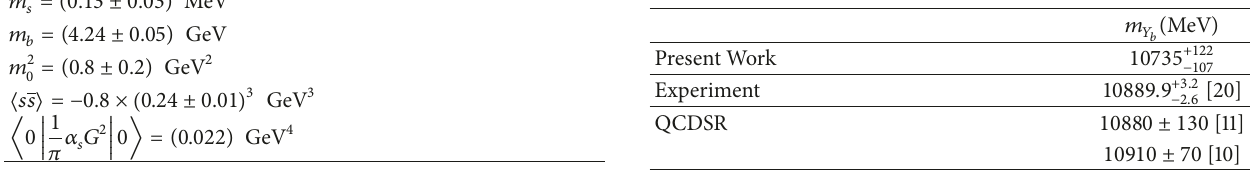
Table 1: Input parameters [20–23]. Table 2: Results obtained in this work for the mass of 𝑌 푏 at 𝑇 = 0 , in comparison with